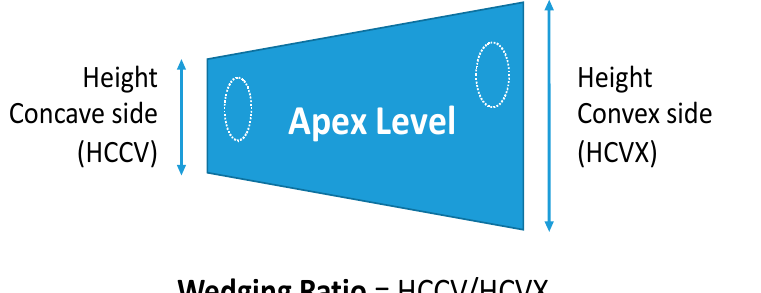
Figure 1. The wedging ratio (WR) represents the effect on the vertebral morphology of the growth of the concave epiphyseal plate at the apical vertebra, and is calculated by the ratio between the height of the concavity and